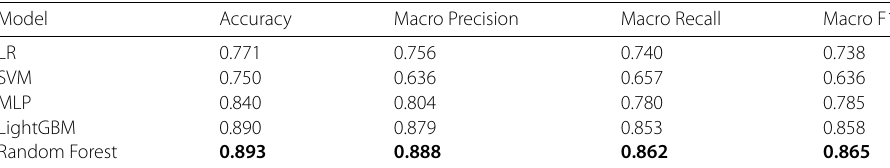
Table 3 The prediction of five classifiers to the sample dataset Model Accuracy